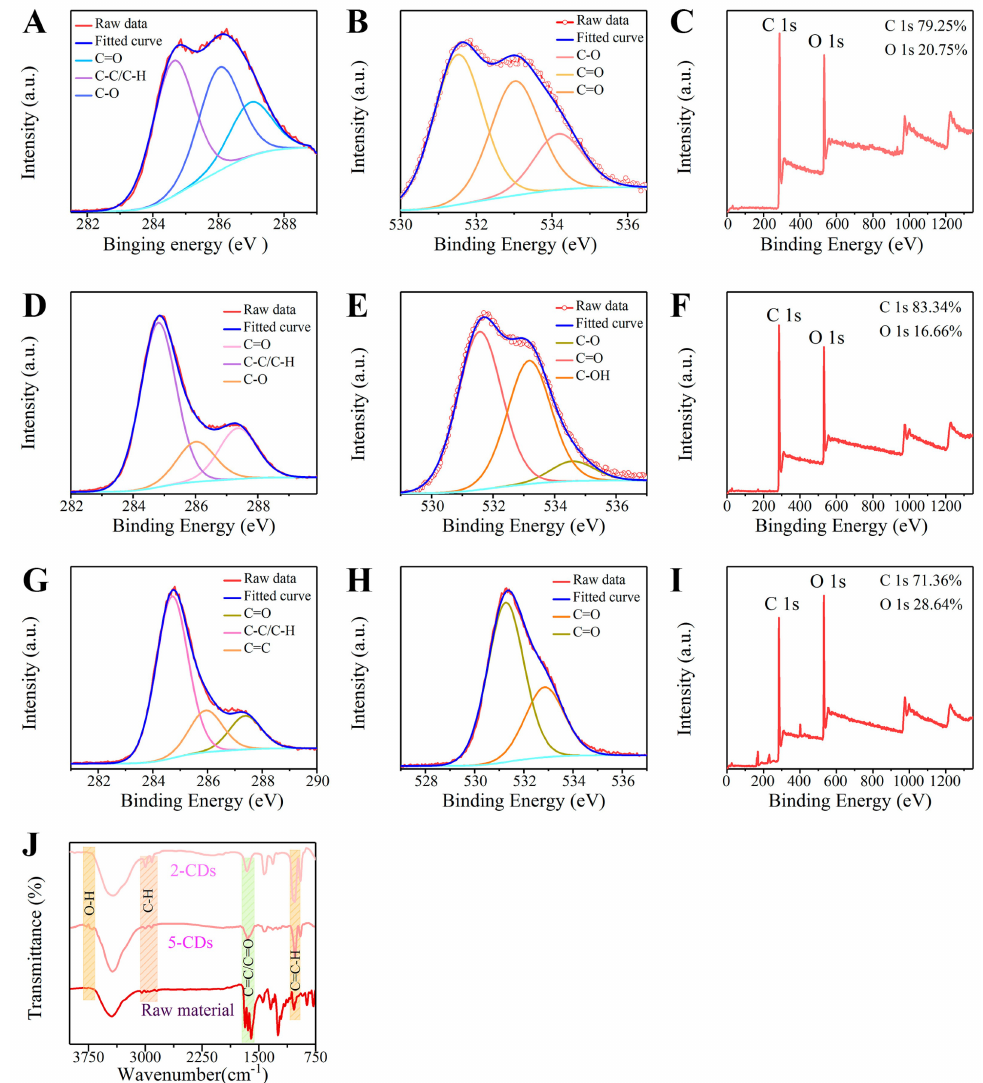
Figure 2. FTIR and XPS analysis. ( A ) Survey XPS spectrum of 2 − CDs and the high-resolution XPS peaks of C1s ( B ) and O1s ( C ). ( D ) Survey XPS spectrum of 5 − CDs and the high-resolution XPS peaks of C1s ( E ) and O1s ( F ). ( G ) Survey XPS spectrum of raw material (2-methoxy-1, 4 -naphthoquinone) and the high-resolution XPS peaks of C1s ( H ) and O1s ( I ). ( J ) FTIR spectra of 2 − CDs, 5 − CDs,